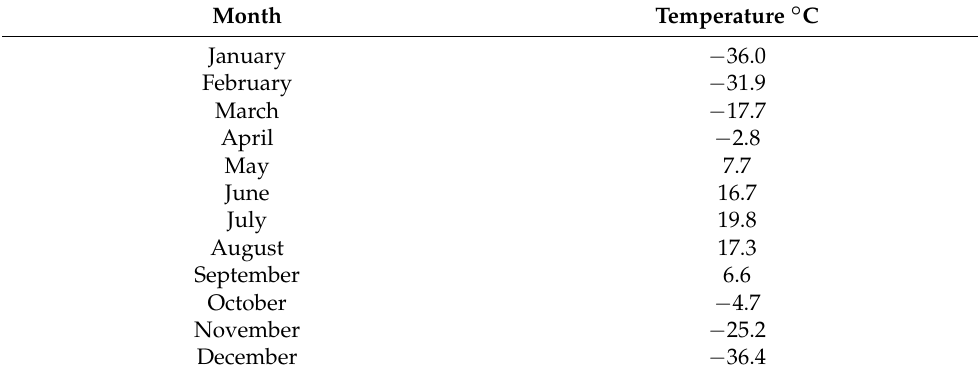
Table 1. Average air